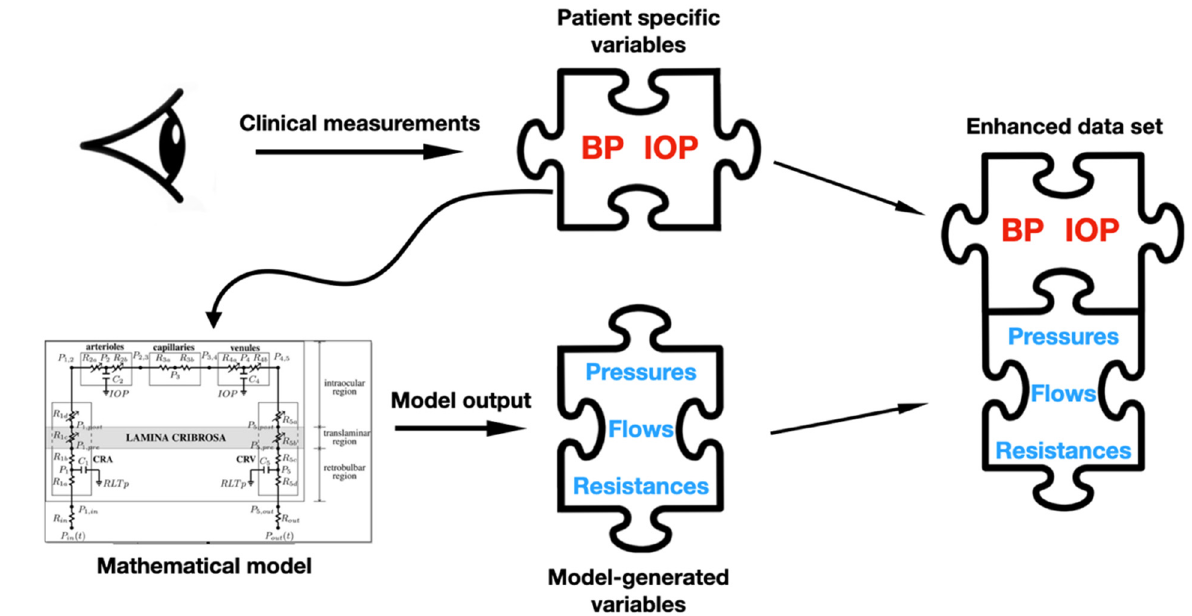
Figure 1. Comparison of Heidelberg retinal tomography (HRT)- vs. optical coherence tomography (OCT)-derived parameters: ( left ) cup area, ( center ) cup to disk area ratio, ( right ) mean retinal nerve fiber layer (RNFL) thickness.